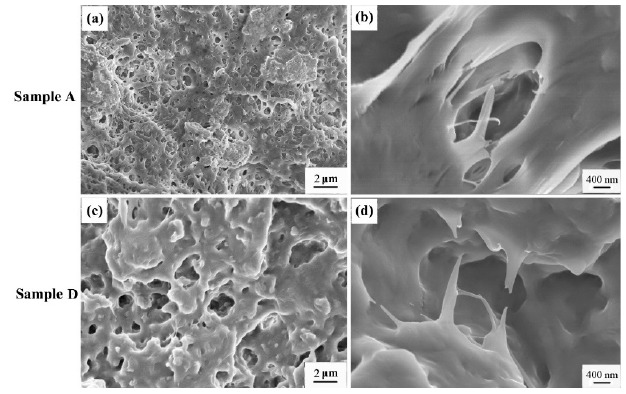
Figure 8. SEM micrographs of tensile fractured surfaces of the samples A and D.